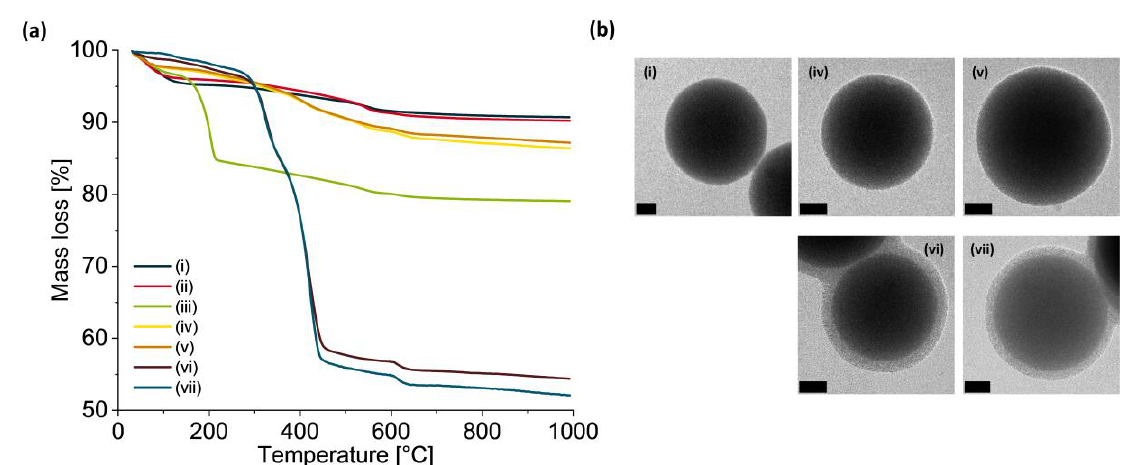
Figure 6. ( a ) TGA mass loss curves of ( i ) SiO 2 particles, ( ii ) APTES@SiO 2 , ( iii ) RAFT@SiO 2 ,